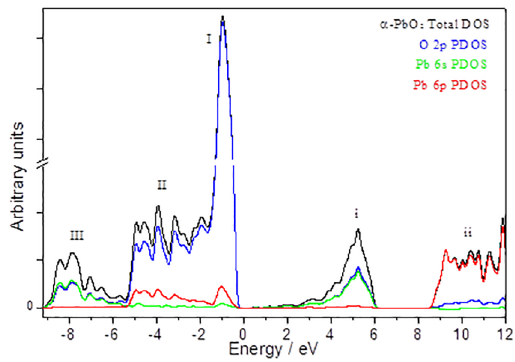
Figure 3. Total and partial DOS diagram for α-PbO